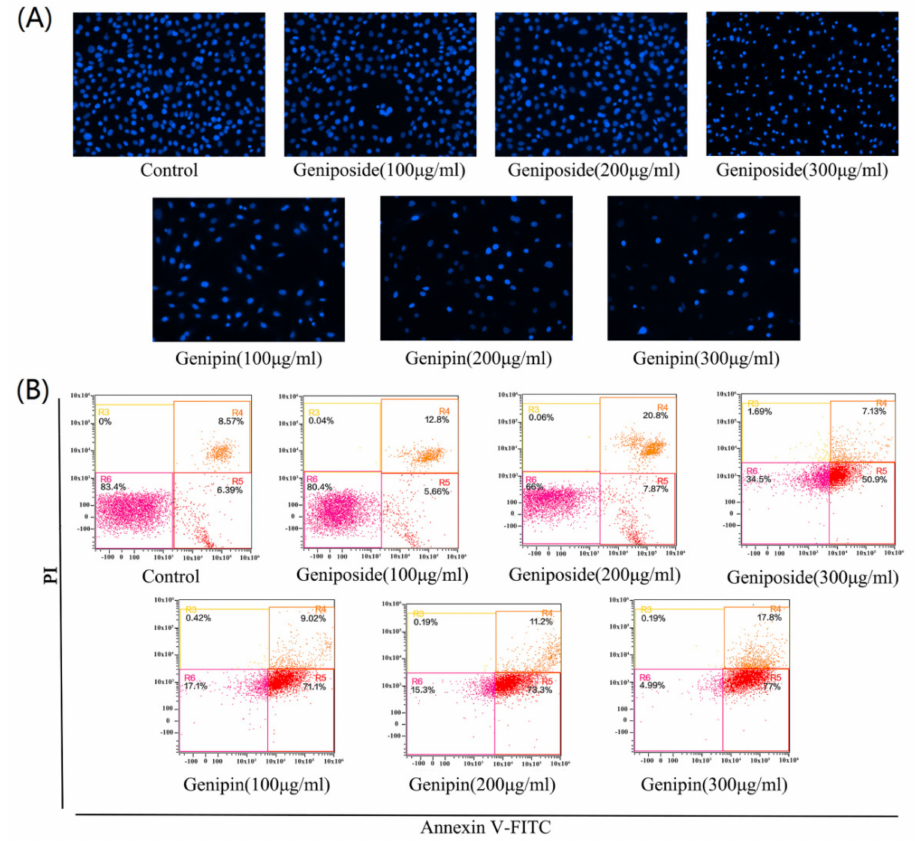
Figure 4. ( A ) DAPI staining results after treatment with geniposide and genipin as photographed